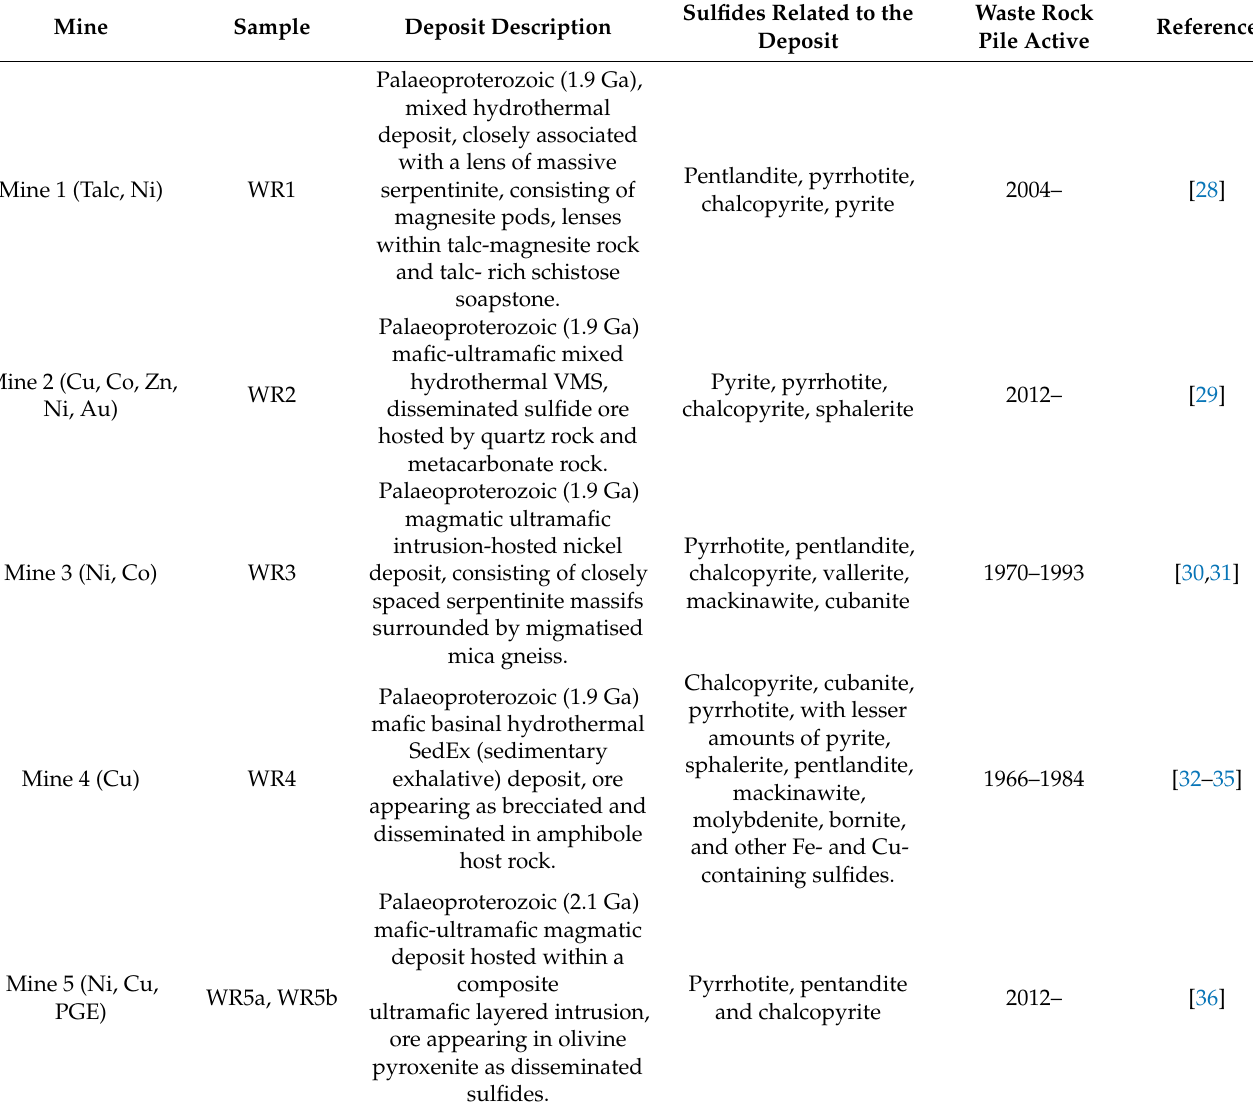
Table 1. The target mine sites and investigated waste rock samples WR1-5b for a detailed study of the HA and AR extractions. Mine Sample Deposit Description